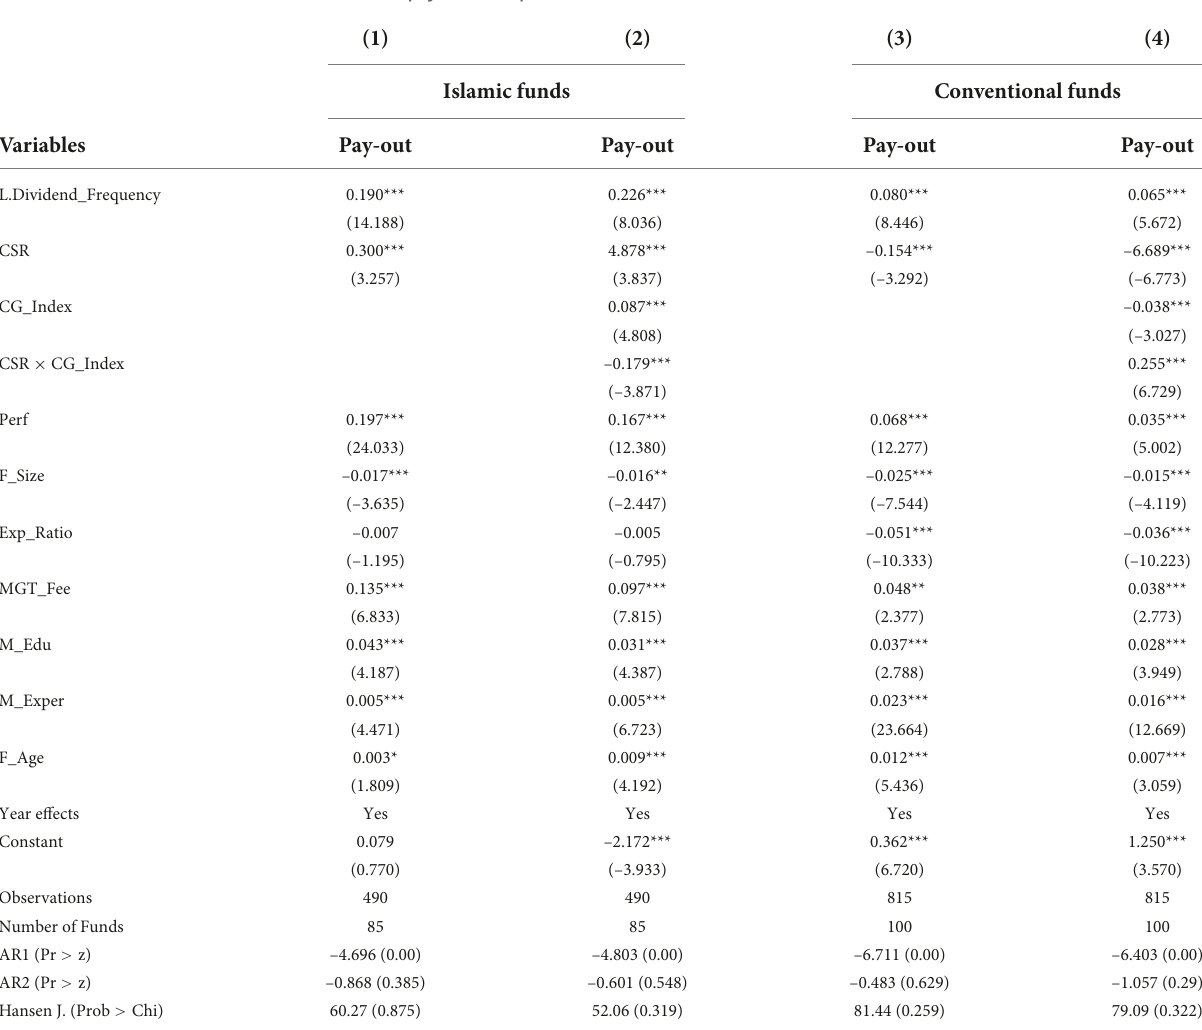
TABLE 5 Islamic vs. conventional funds: dividend pay-out as dependent